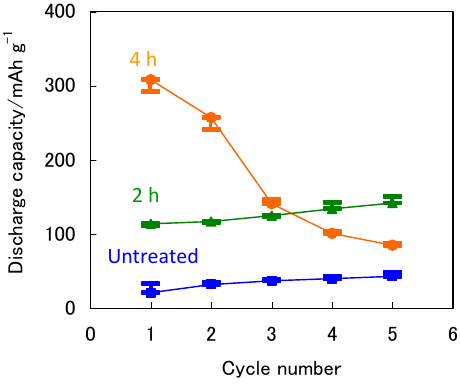
Figure 2. Discharge capacities as a function of the cycle number for the ZrNi negative electrodes with and without the boiling alkaline treatments for 2 h and 4 h at 333 K.